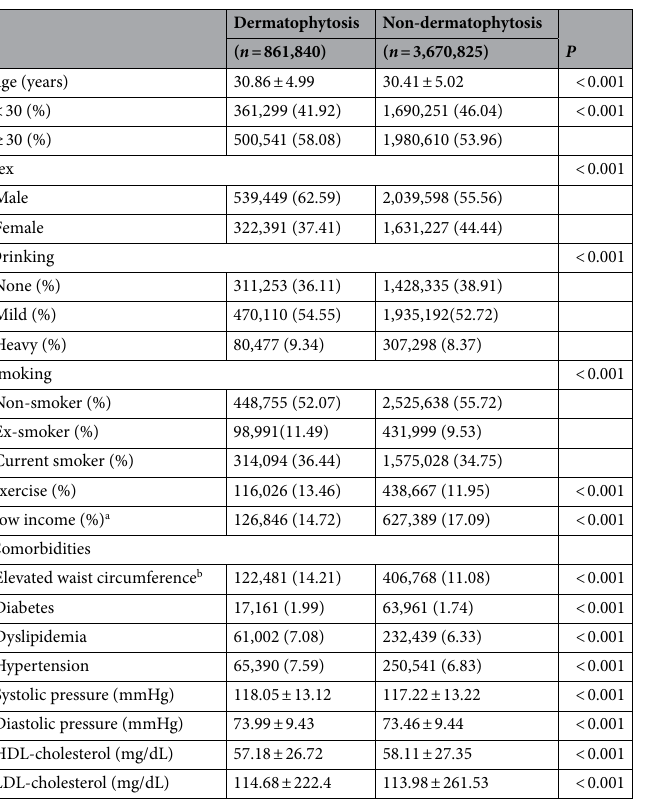
Table 1. Characteristics of the study population. Values are expressed as mean ± standard deviation or n (%) by independent t-test (continuous variables) or chi-squared test (categorical variables). HDL high-density lipoprotein, LDL low-density lipoprotein. a Low income is defined as a household income of 20% or less of the median. b Elevated waist circumference is defined as a waist circumference of more than 90 cm in men or more than 85 cm in